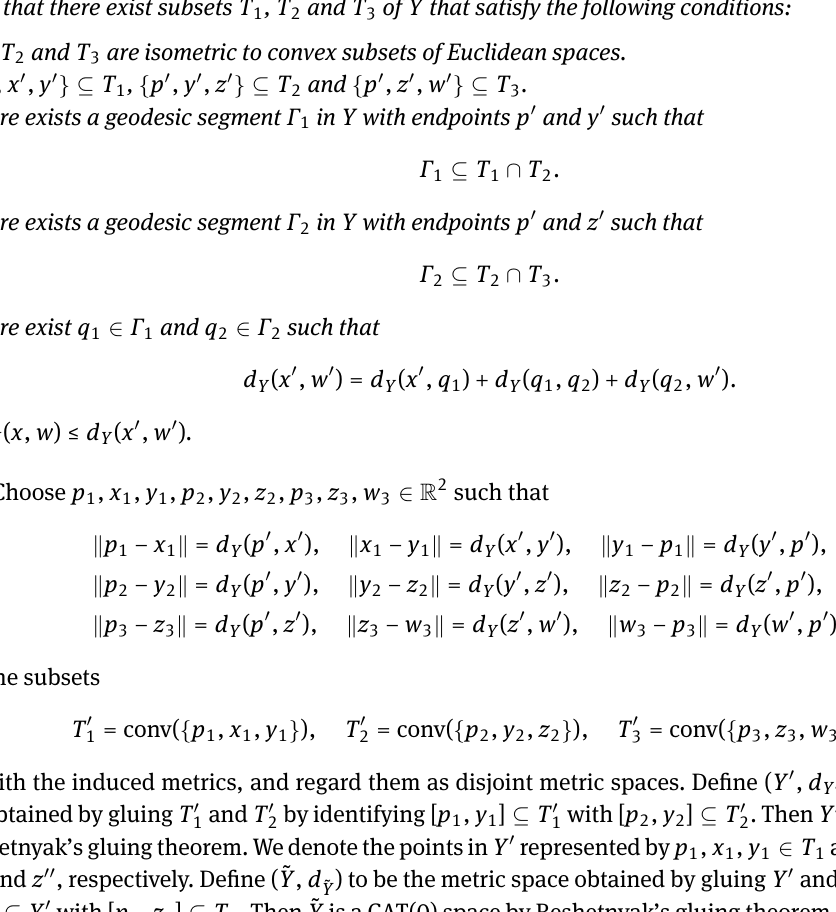
respectively. For each i ∈ { 1, 2, 3 } , the natural inclusion of T (cid:48)